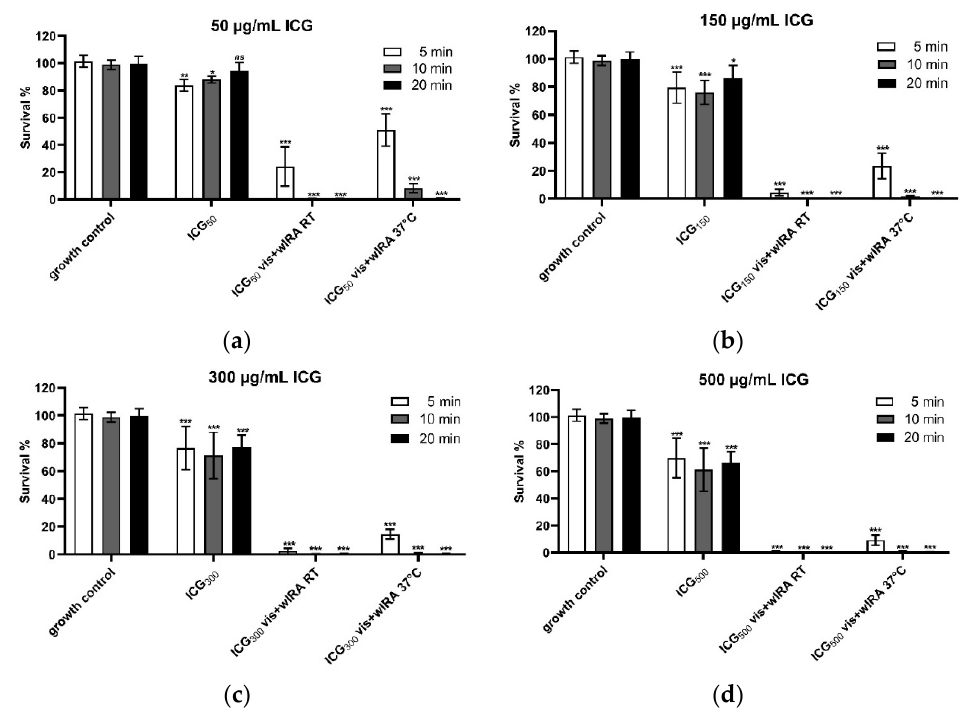
Figure 5. Cell viability after treatment with ( a ) 50, ( b ) 150, ( c ) 300, and ( d ) 500 µg/mL ICG and Vis + wIRA. Human gingival keratinocytes were incubated with different concentrations of ICG at RT or 37 °C with or without Vis + wIRA radiation for 5 min, 10 min, or 20 min. Cell viability was analyzed with the AlamarBlue assay. The associated p -values compared to the growth control are specified. ns : p > 0.05; * p < 0.05; ** p < 0.01; *** p <